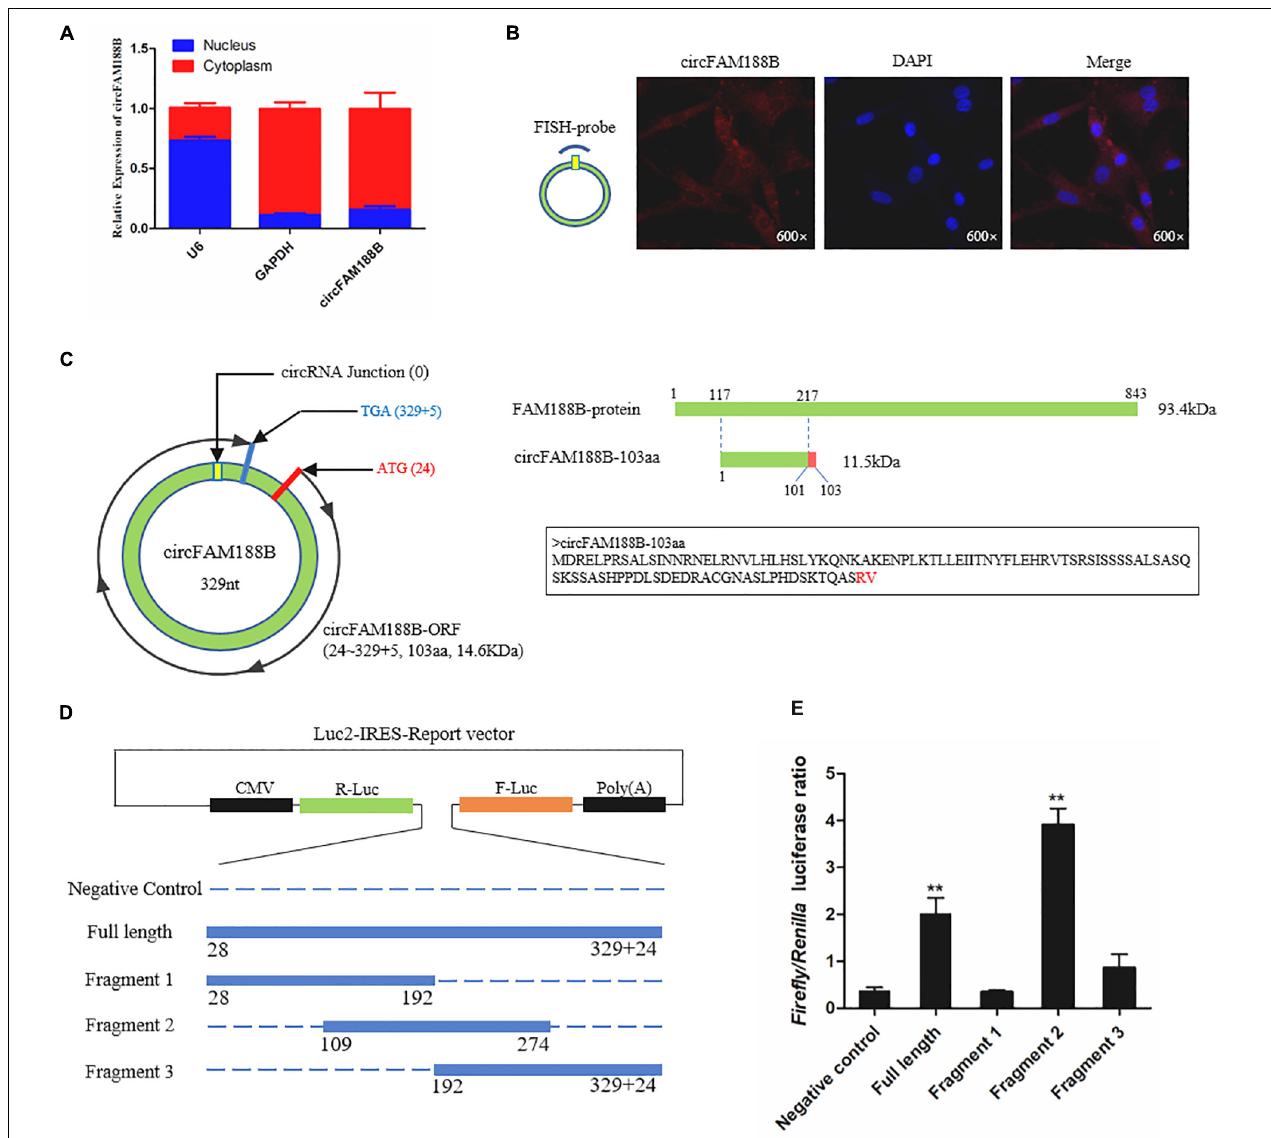
FIGURE 4 | CircFAM188B is located in the cytoplasm with coding potential. (A) CircFAM188B expression levels in the cytoplasm (red) and nuclei (blue) of undifferentiated SMSCs. (B) FISH assay of circFAM188B in chicken SMSCs. (C) Schematic diagram of circFAM188B-103aa. (D) Schematic diagram of the dual-luciferase reporter (Luc2-IRES-Reports vector) containing different fragments of circFAM188B, which was used for IRES verification. (E) Ratio of Firefly luciferase to Renilla luciferase activity of DF-1 cells after transfection with dual-luciferase reporter vectors shown in (D) . The results of all groups are shown as mean ± S.E.M., and the data represent three independent assessment methods. Student’s t -test was used to compare expression levels or values among different groups. * P < 0.05; ** P < 0.01.